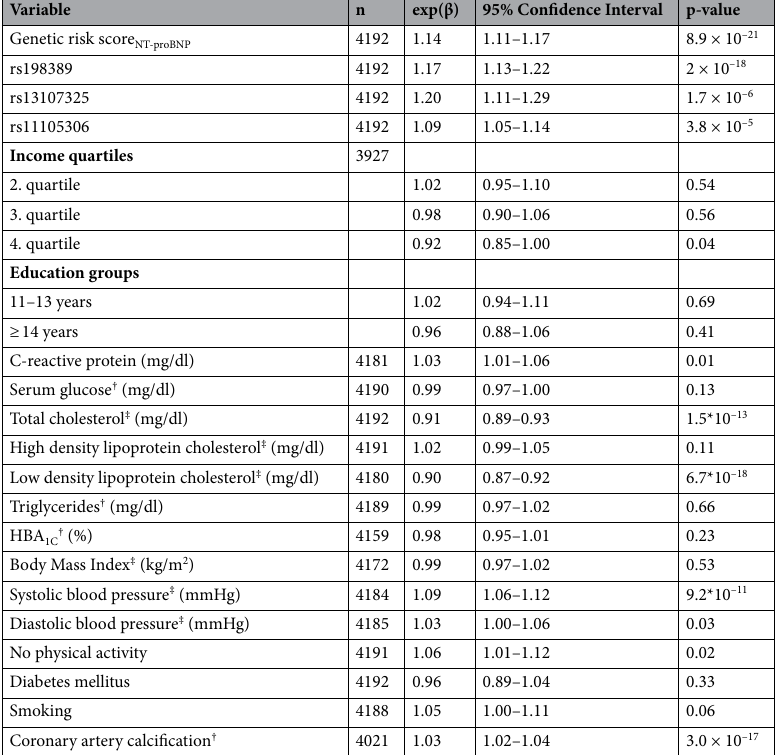
Table 5. Exp(β) and 95% confidence intervals (95% CI) for the association of genetic, socioeconomic and cardiovascular risk factors with NT-proBNP in separate linear regression models, adjusted for sex and age, including only participants with no stroke, no coronary artery disease and glomerular filtration rate > 30 ml/ min/1.73m 2 at baseline (lowest income/education group as reference). ‡ Exp(β*standard deviation(β)). †